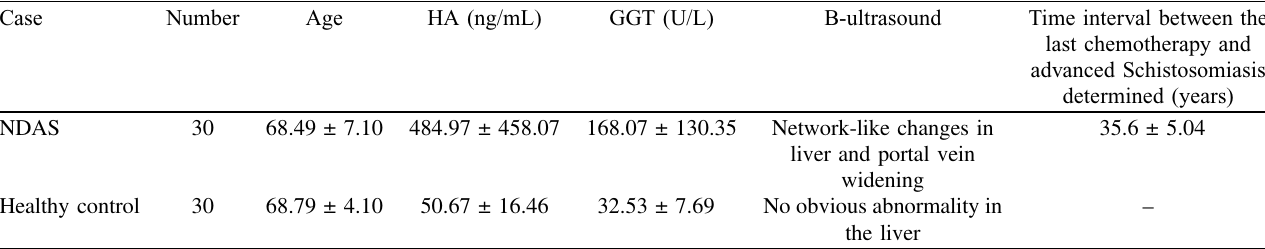
Table 1. Newly developed advanced schistosomiasis (NDAS) patients identi fi ed by historical survey, liver B-ultrasound scan and serological examination, 30 healthy people were selected as negative